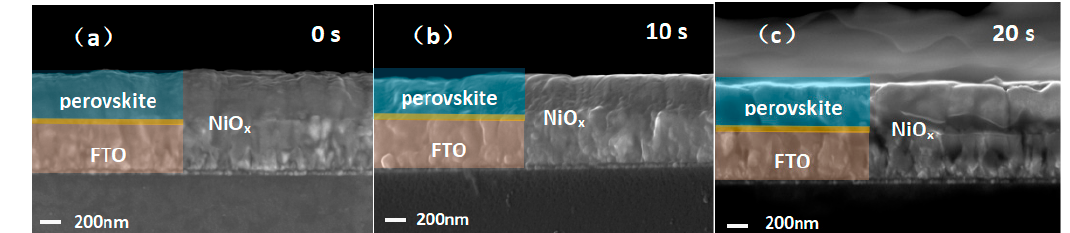
Figure 2. ( a – c ) Cross-sectional views of organic–inorganic hybrid perovskite films with different PbI 2 annealing times.